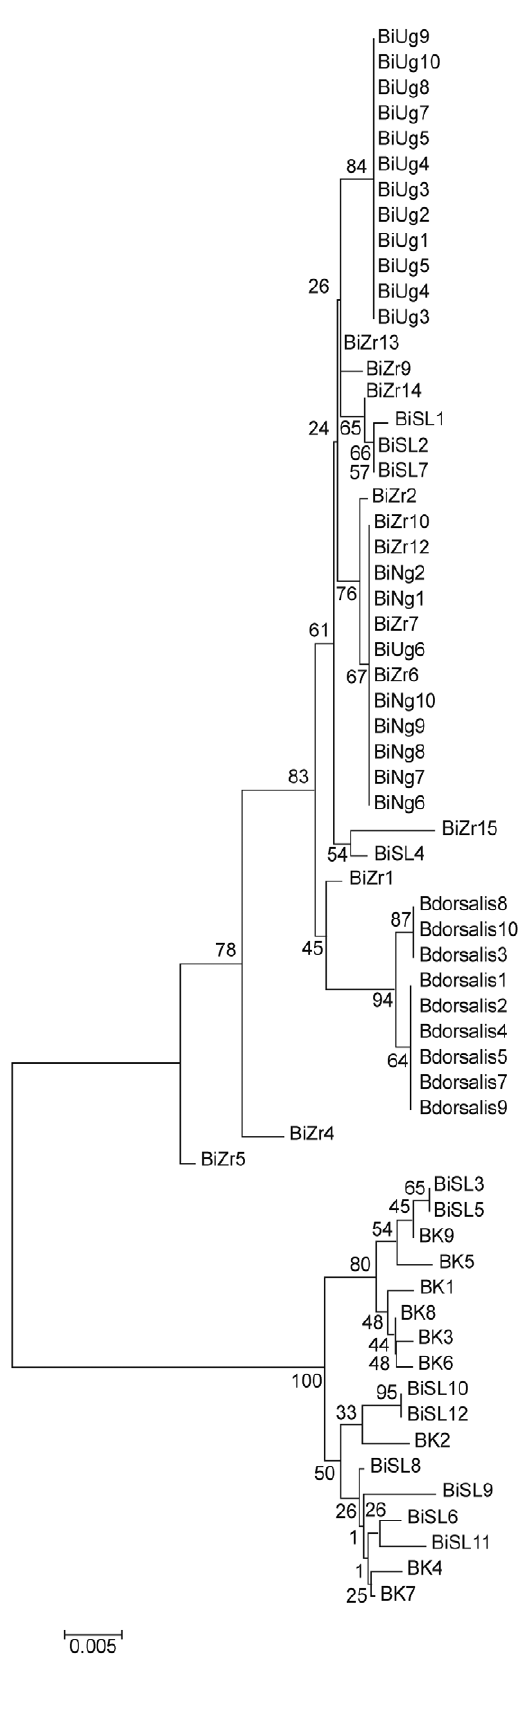
Figure 3. Evolutionary relationships between Bactocera inva- dens populations, B. dorsalis s.s and B. kandiensis as inferred using Neighbour-Joining method by Mega 5 program (Tamura etal. ,